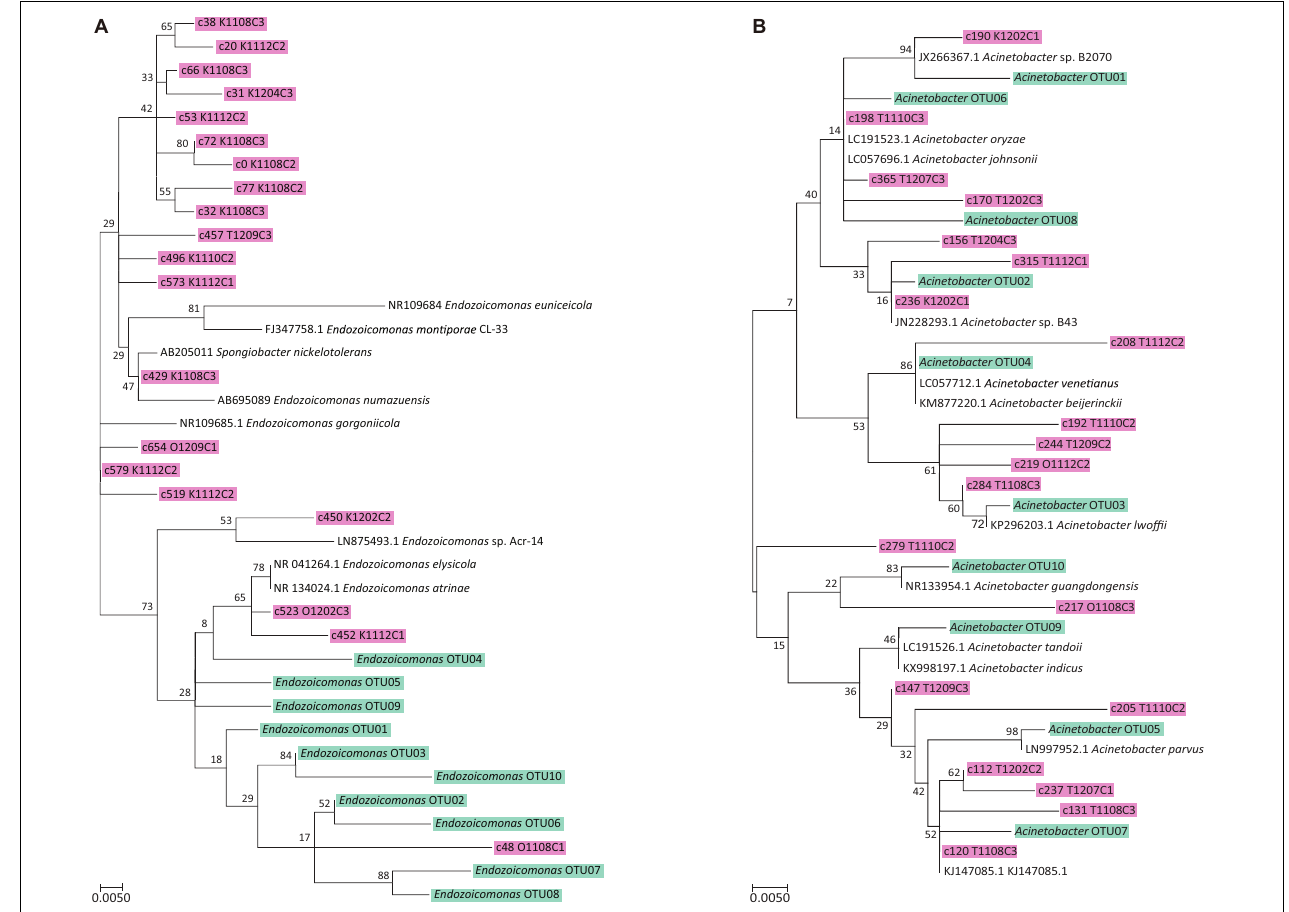
FIGURE 5 | Maximum likelihood trees of top 20 OTUs Endozoicomonas and Acinetobacter . (A) ML tree of top 20 Endozoicomonas OTUs from this study (shown in pink) and top 10 Endozoicomonas OTUs from coral Stylophora pistillata in Yang et al. (2017) (shown in blue). (B) ML tree of top 20 Acinetobacter OTUs from this study (shown in pink) and top 10 Acinetobacter OTUs from coral S . pistillata in Yang et al. (2017) (shown in blue). The trees with the highest log likelihood ( − 1227.6999) and 1,000 bootstraps. The analysis involved 42 nucleotide sequences. All positions containing gaps and missing data were eliminated. There were a total of 295 positions in the final